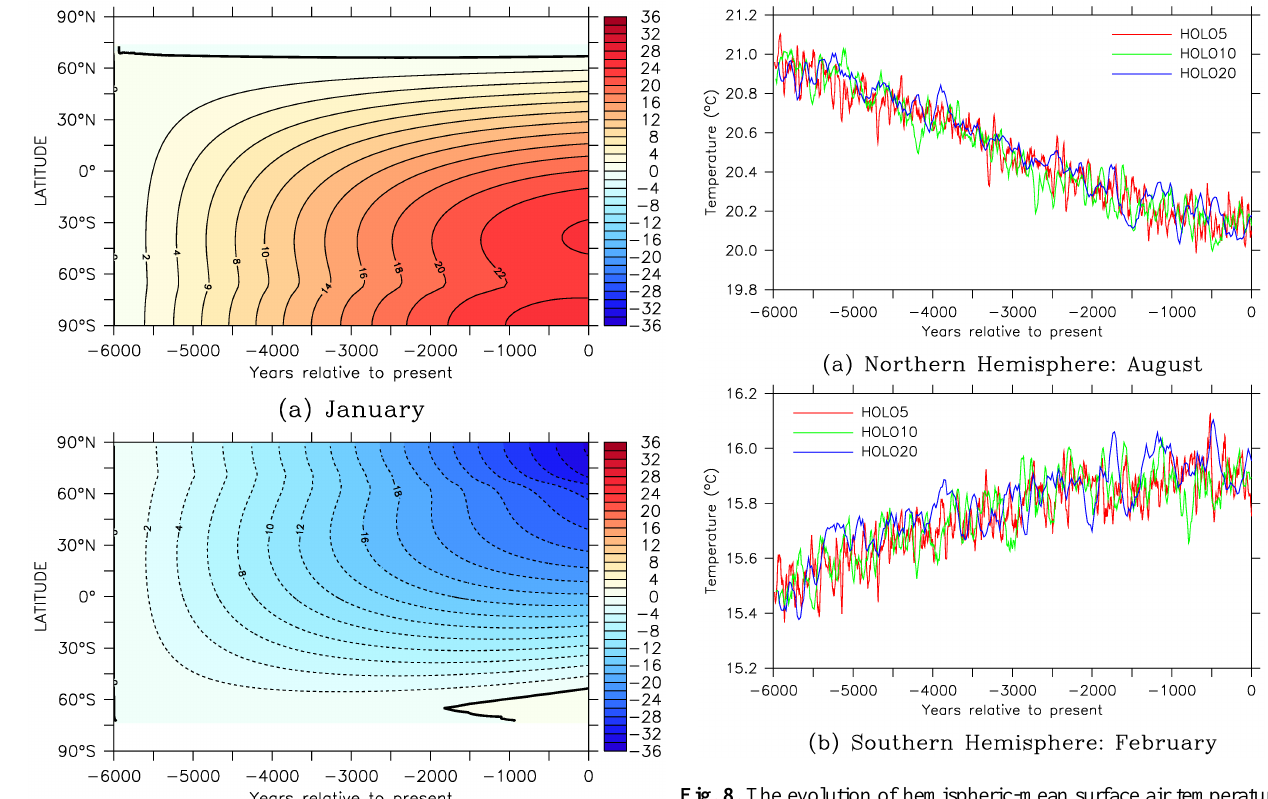
Fig. 8. The evolution of hemispheric-mean surface air temperature during experiments HOLO5 (red), HOLO10 (green) and HOLO20 (blue): (a) Northern Hemisphere, August, and (b) Southern Hemi- sphere, February. The values shown are running means across five model